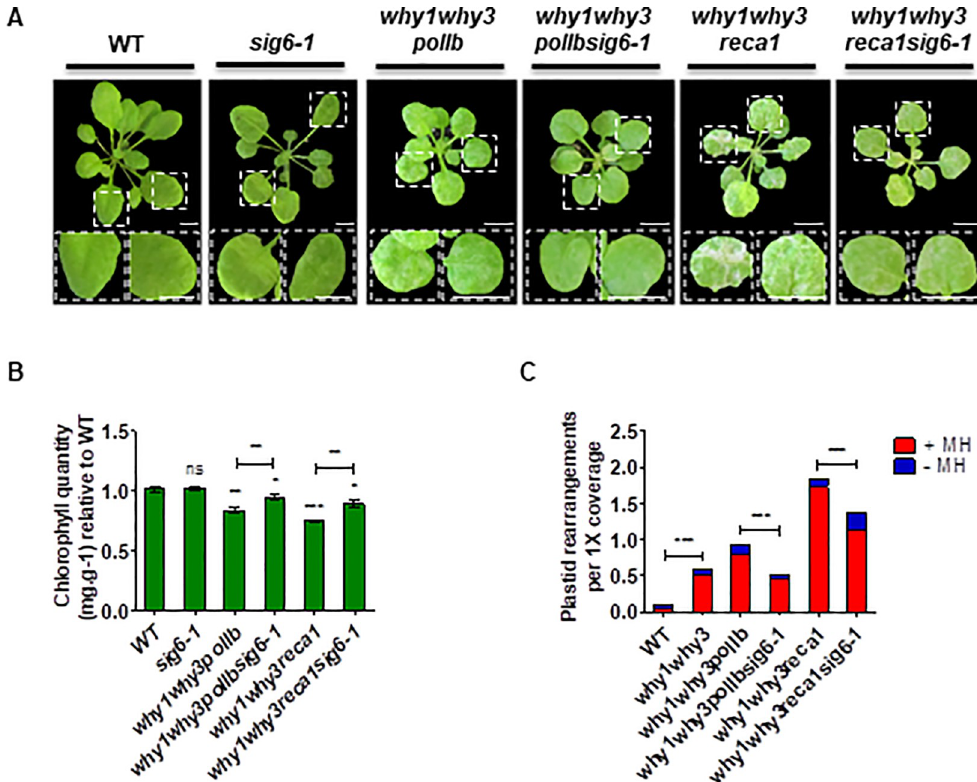
Fig 4. SIG6 mutation partially complements why1why3polIb and why1why3reca1 phenotypes. (A) Representative photographs of Arabidopsis wild type (WT), why1why3polIb , why1why3polIbsig6-1 , why1why3reca1 , why1why3reca1sig6-1 , and sig6-1 mutant plants grown 28 days on soil. Bar = 0.5 cm. (B) Histogram showing the quantification of chlorophyll a and b (mean ± standard error) of plants described in A relative to WT (n = 6, 10, 10, 10 and 6, respectively). Mann Whitney test, (ns: not significant, � : p < 0.05, �� : p < 0.01, ��� : p < 0.001). (C) DNA-seq analysis of WT, why1why3 , why1why3polIb